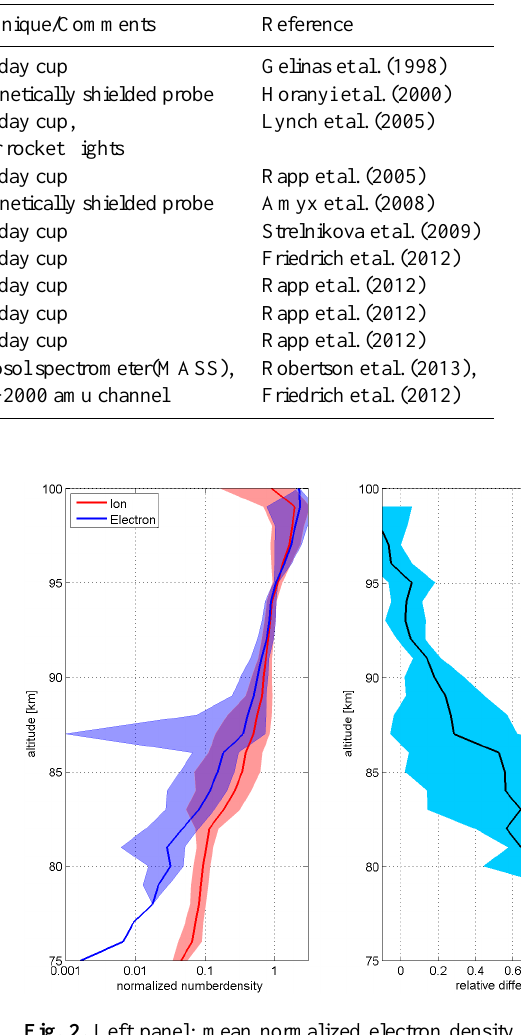
Table 1. Collection of in situ measurements of charged MSP during darkness; the labels are used for the MSP height profiles in Fig. 1, the last five flights measured plasma densities simultaneously, mean values are shown in Fig. 2.